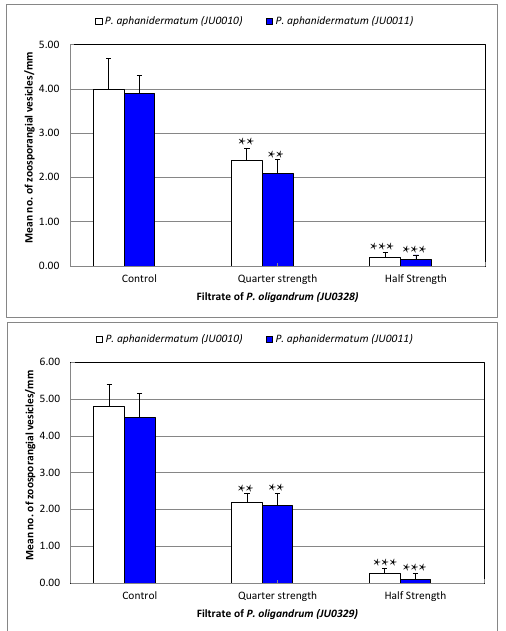
Fig. 1. Effect of cultural filtrate of two isolates of P. oligandrum on zoospore production by two isolates of P. aphanidermatum after 24 h at 20°C in the dark. Bars above all drawing column, represent the standard error of the average data from three replicates and reflect differences between averages of the samples compared to the control sample. Significant values against control represent: ** = highly significant at p < 0.01, *** = very significant at p <